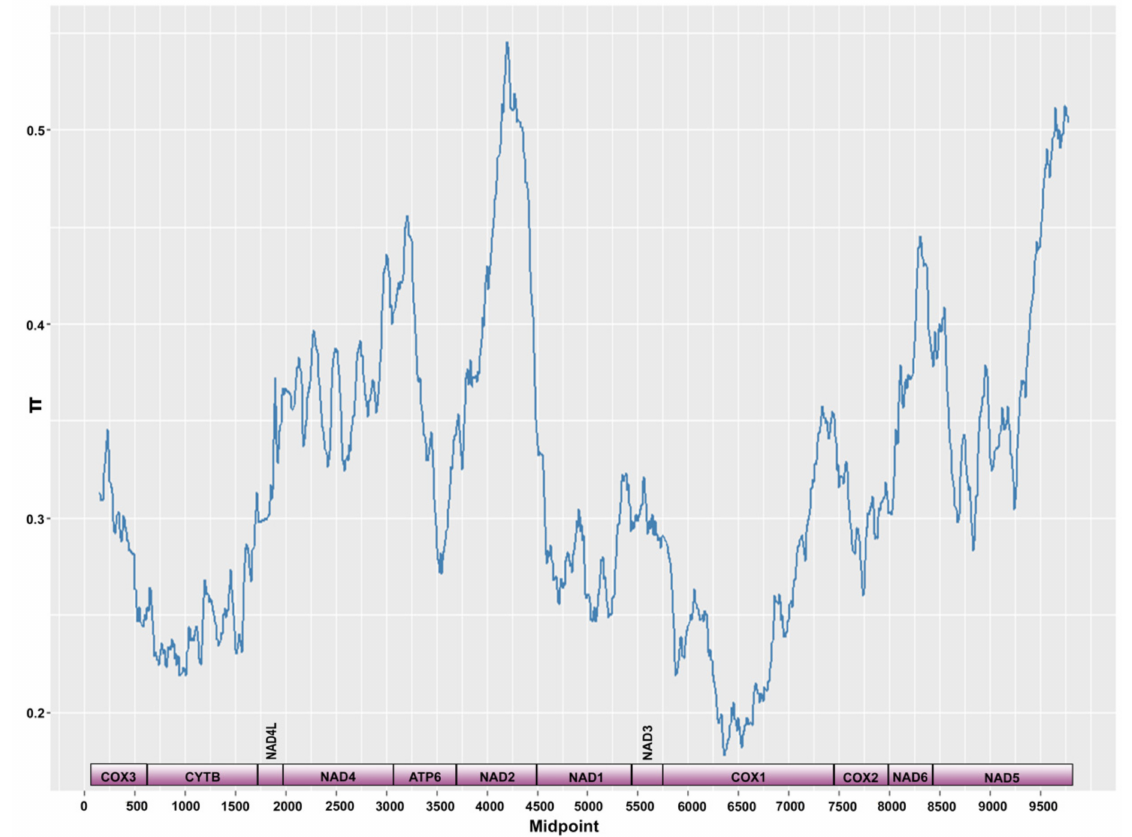
Figure 7. Sliding window analysis (window size 300 bp, step size 10 bp) of the alignment of mitochondrial protein-coding genes of the three complete mitochondrial genomes of Cichlidogyrus spp. ( C. casuarinus MZ703276, C. halli MG970255.1 and C. sclerosus JQ038226.1). The line indicates the nucleotide diversity with gene boundaries indicated below the